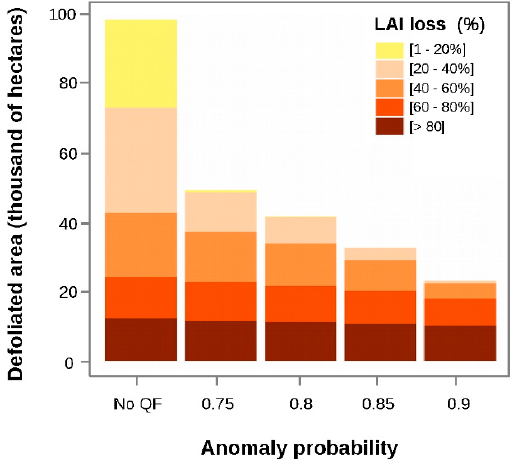
Figure 9. Defoliated area on day of the growing season (DGS) 268 when applying different values of the anomaly probability flag.